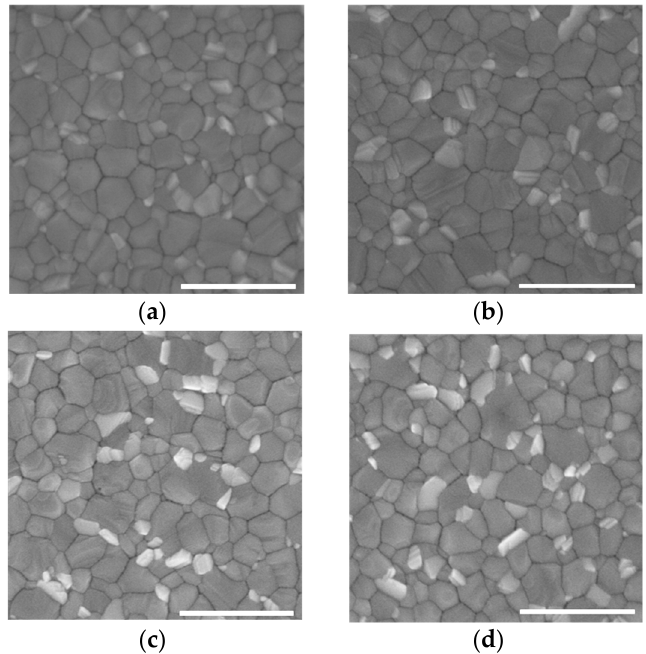
Figure 3. SEM images of perovskite films. ( a ) The control perovskite film. ( b ) Perovskite film treated with 0.075 mg/mL MoS 2 QDs. ( c ) Perovskite film treated with 0.10 mg/mL MoS 2 QDs. ( d ) Perovskite film treated with 0.15 mg/mL MoS 2 QDs. Scale bar: 1 μ m.